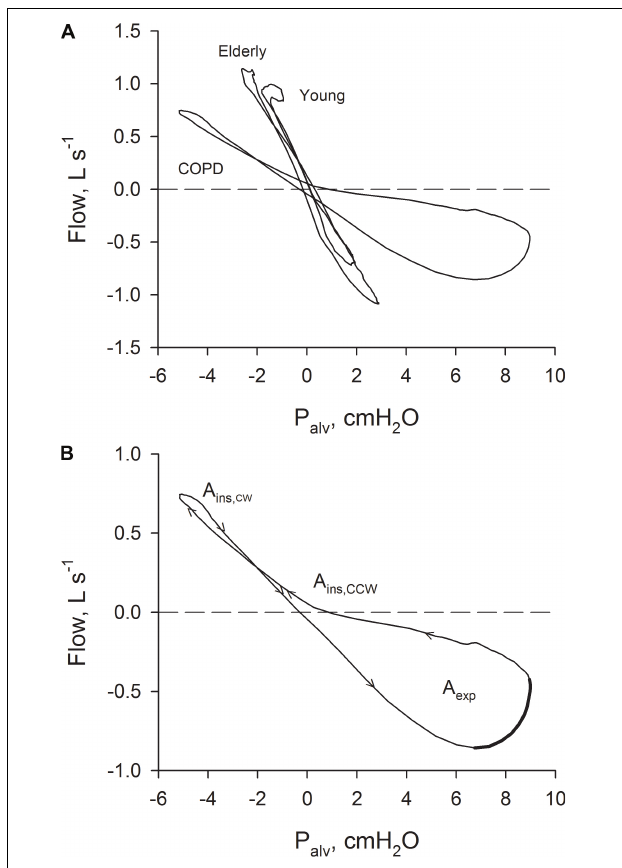
FIGURE 1 | (A) Relations between P alv – ˙V recorded in a young healthy subject, in an old healthy subject and in a patient with severe COPD. (B) Relation between P alv – ˙V recorded in a patient with severe COPD with the indication of the sense of rotation (arrows). A ins : inspiratory area; A exp : expiratory area. The part of the expiratory P alv – ˙V suggestive of the presence of expiratory flow-limitation (where flow is decreasing while driving pressure is increasing) is indicated with a thicker